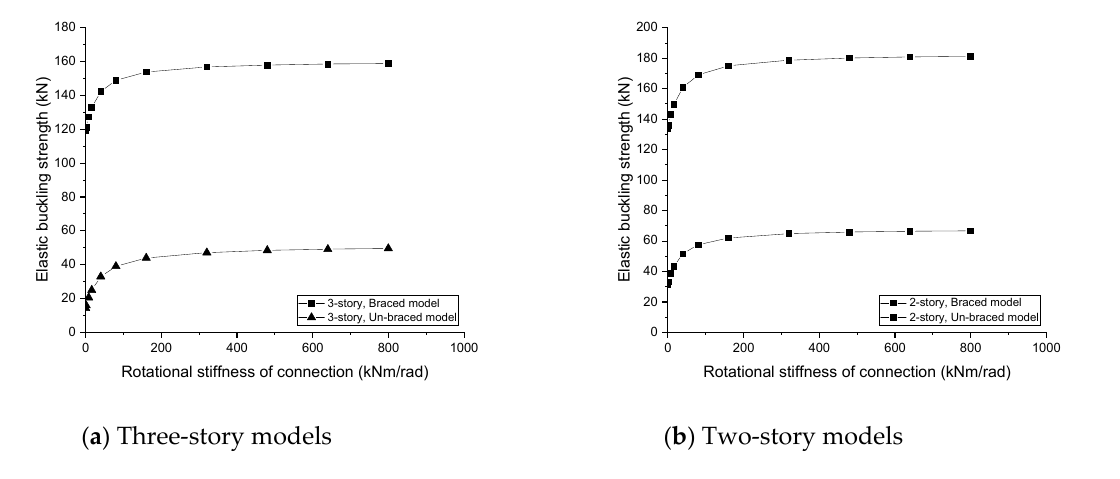
Figure 15. Variation of elastic buckling strength according to the rotational stiffness of the connection. Table 10. Elastic buckling strength when applying rotational stiffness (16.0 kNm/rad).